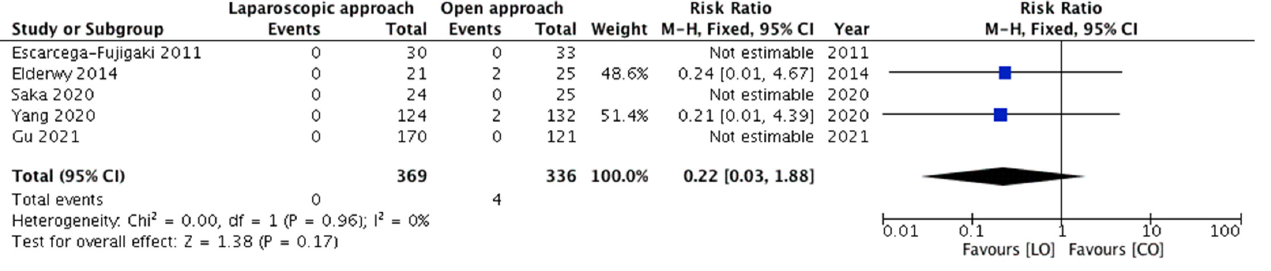
Figure 2. Forest plot comparison between the two treatment groups for the need for